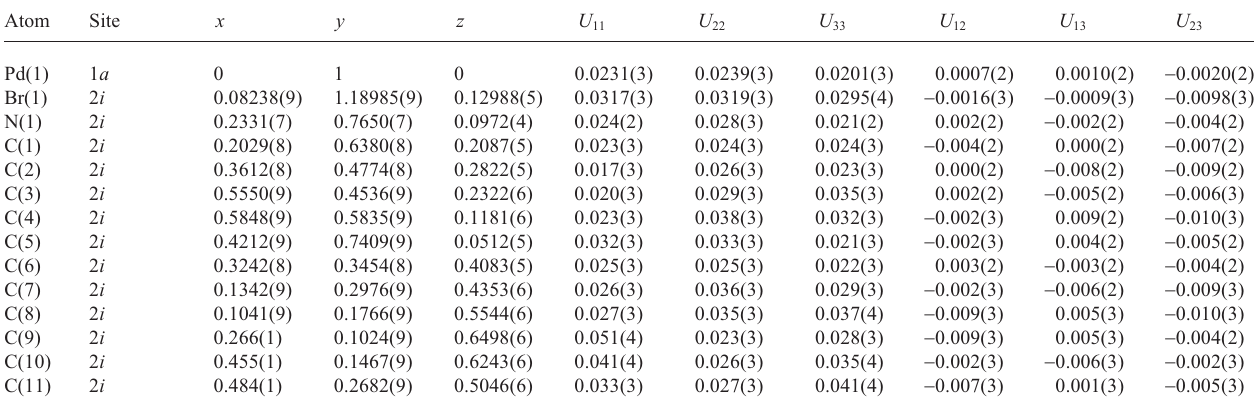
Table 3. Atomic coordinates and displacement parameters (in Å 2 )